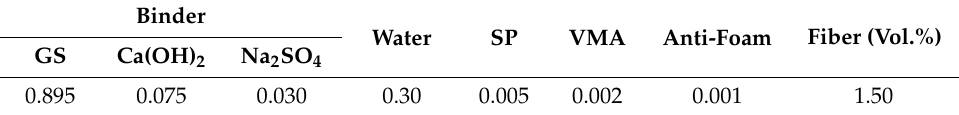
Table 1. Mixture proportion (weight ratios of binder).